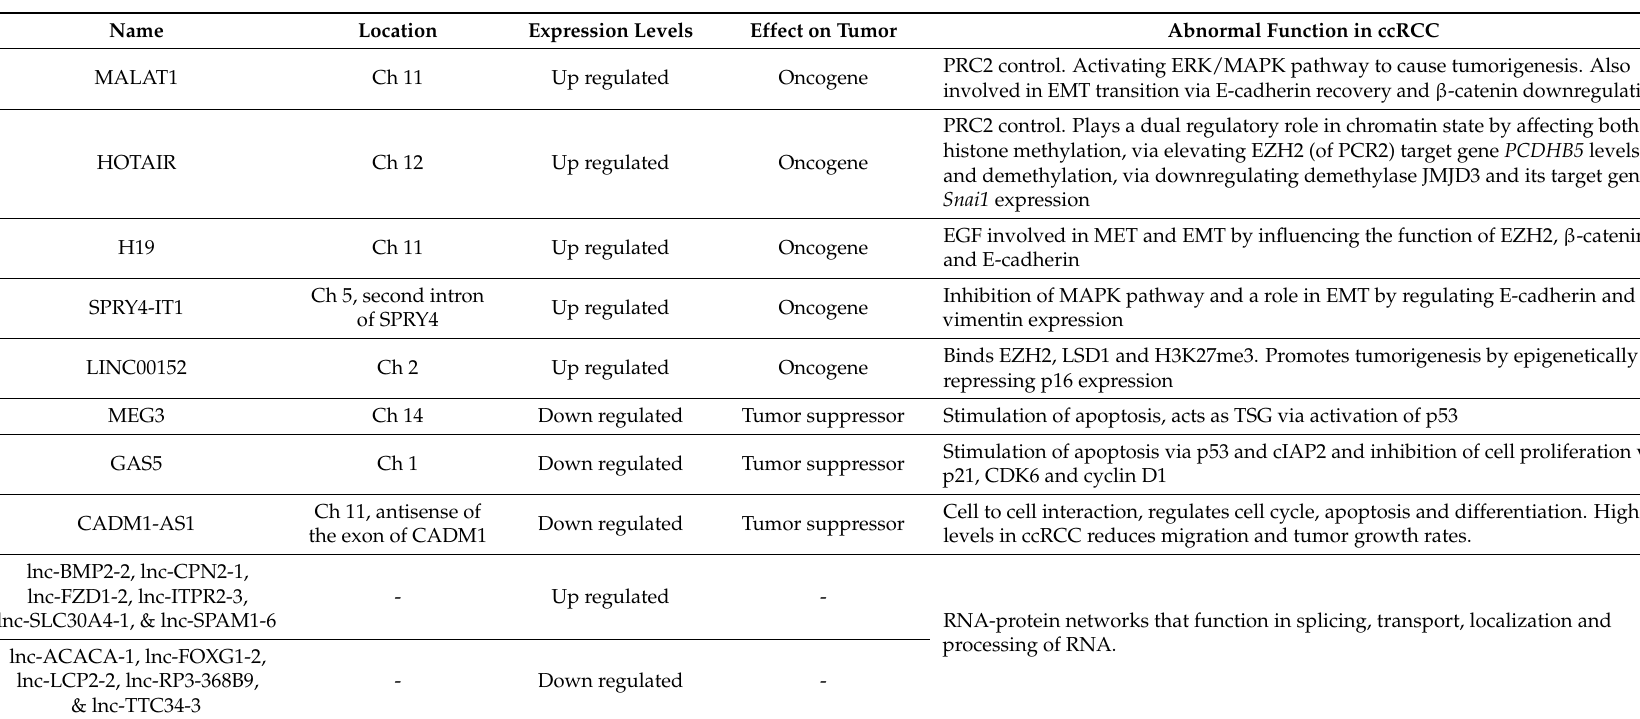
Table 1. Newly identified lncRNAs along with their location, expression and abnormal function in ccRCC. EGF, embryonic growth factor; EMT, epithelial-mesenchymal transition; MET, mesenchymal–epithelial transition; TSG, tumor suppressor gene; LSD1, lysine (K)-specific demethylase 1A (LSD1) or KDM1A; Ch,